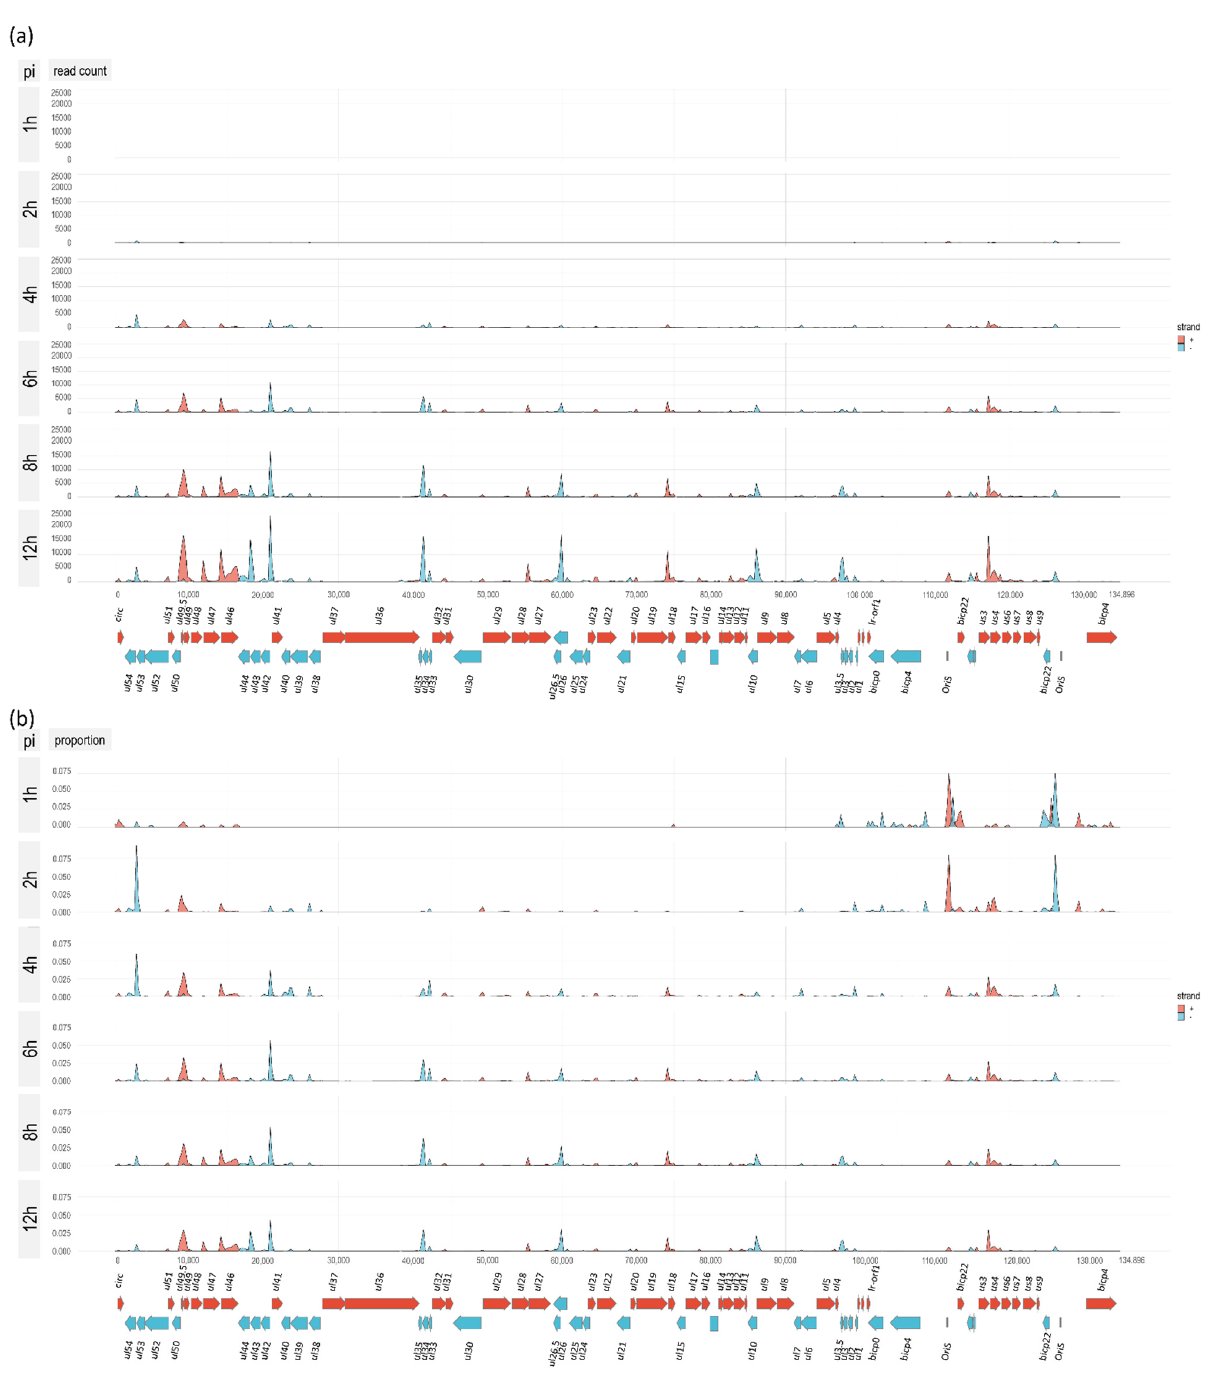
Figure 4. Time-course genome-wide expression of TSSs. This figure shows the TSS distribution along the BoHV-1 genome in a time-varying manner using a density plot. ( a ) The Y -axis shows the number of TSSs using the same scales. Red color indicates left-to-right orientation of the TSSs, while blue color indicates the opposite orientation of the TSSs and of course, the same is true for the corresponding genes. ( b ) This panel shows the proportion of TSSs within the total TSS. While the number of TSSs can be reliably compared for the same TSS at different time points, the different TSSs cannot be compared due to the size preference of sequencing.